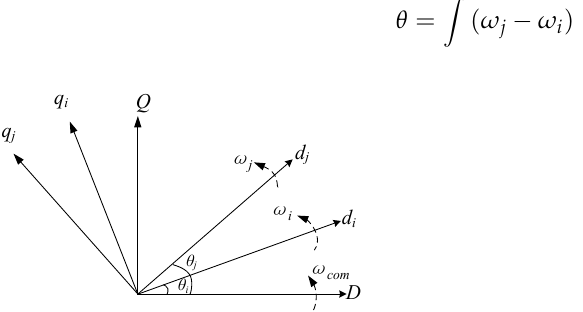
Figure 4. Transformation of the uniform coordinate system.